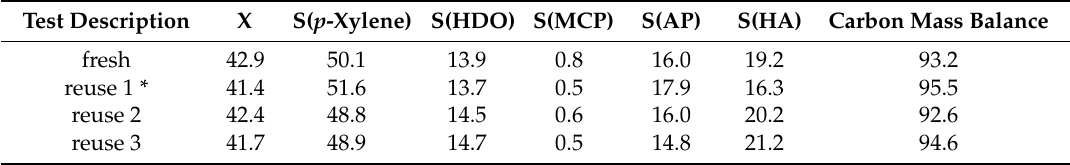
Table 3. Catalyst Z80.2 reusability results in the Diels–Alder cycloaddition of 2,5-dimethylfuran